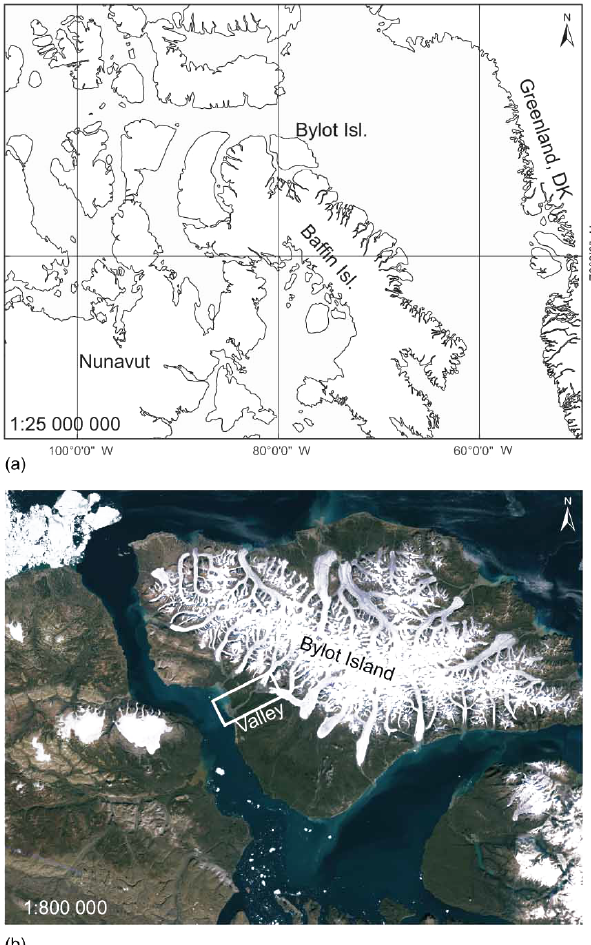
Figure 1. The study site is on Bylot Island in the Canadian Arctic archipelago (73 ◦ 09 (cid:48) N, 79 ◦ 57 (cid:48) W), north of Baffin Island (a) . The valley of Qalikturvik is located in the southwestern section of the island (b) (background: NRCan Landsat-7 orthorectified mosaic, 3 August